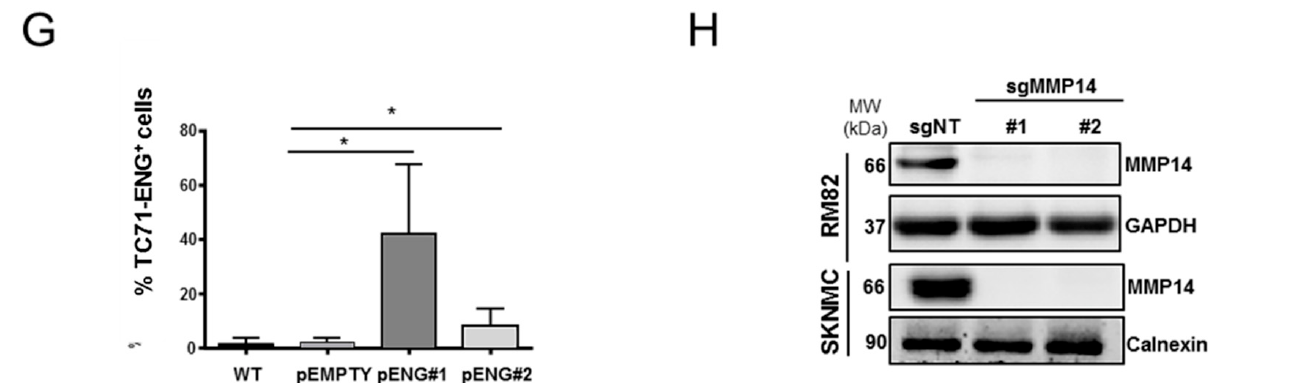
Figure 1. ENG and MMP14 are associated with poor prognosis in ES. Development of ES experimental models silencing/overexpressing ENG and lacking MMP14. ( A ) Kaplan–Meier curve associated with the survival of ES primary patients with high and low ENG expression (n = 196; p = 0.0275). ( B ) Percentage of ES patients presenting a negative-low or intermediate-high score of ENG expression in the local cohort of patients stratified according to clinical stage (n = 83). ( C ) Kaplan–Meier curve associated with the survival of ES primary patients with high and low MMP14 expression (n = 196; p = 0.0194). ( D ) Percentage of ES patients presenting a negative-low or intermediate-high score for MMP14 expression in the local cohort of patients stratified according to the clinical stage (n = 83). Grehan–Breslow–Wilcoxon test was used to analyze patient survival. ( E ) Generation of knockdown models of ENG in the RM82 and SK-N-MC cell lines and candidate clones were confirmed by WB. ( F ) Generation of TC71 ENG-overexpressing models, as confirmed by WB for ENG and HA-tag. ( G ) Validation of ENG overexpression at the cell membrane in the TC71 model. ( H ) Validation by WB of the MMP14 knockout in two clones derived from the SK-N-MC and RM82 cell lines. Paired two-tailed Student’s t -test was used to evaluate statistical significance (* p <